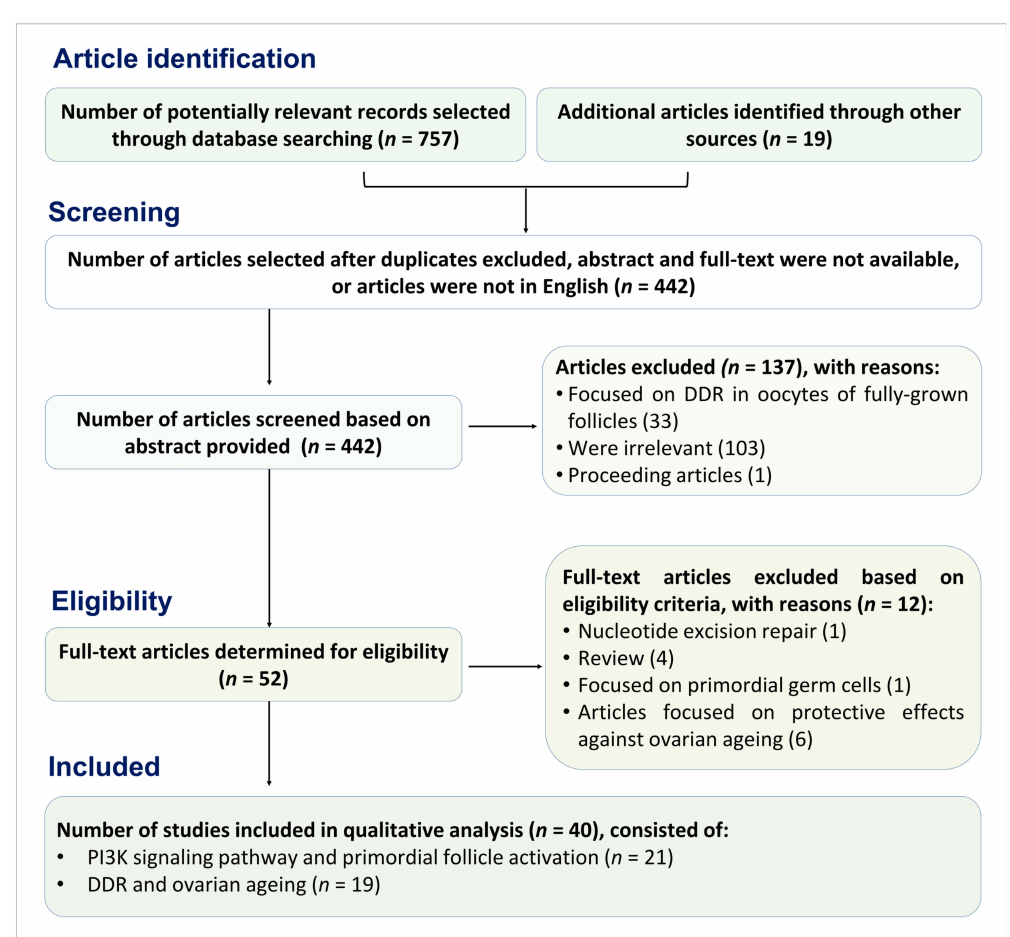
Figure 1. Flow chart following Preferred Reporting Items for Systematic Reviews and Meta-Analyses (PRISMA) guidelines to determine the study included into qualitative